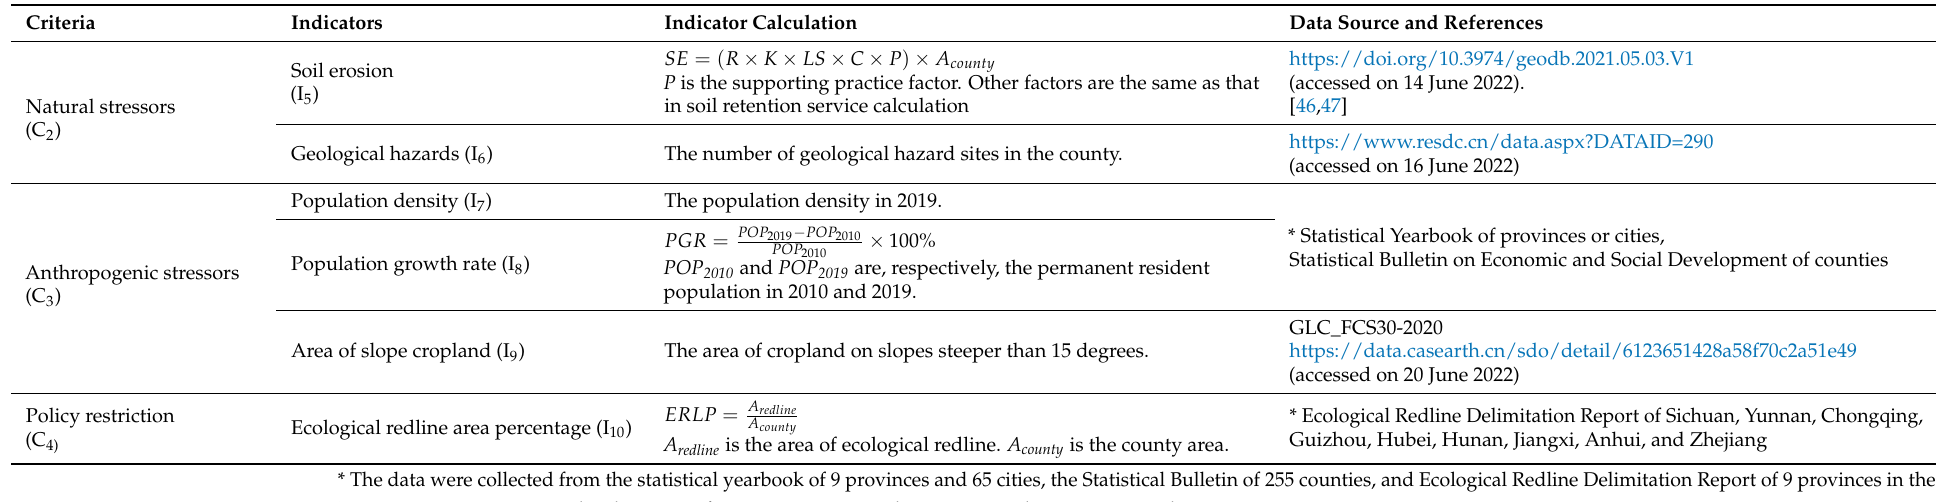
Table 2. Criteria and indicators for evaluating ecosystem protection cost (EPC).